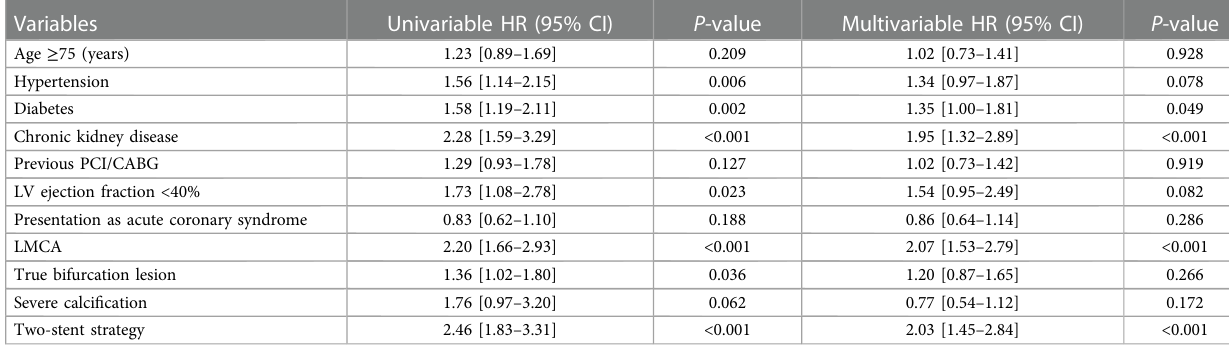
TABLE 3 Predictors of the primary outcome in the overall cohort. Variables